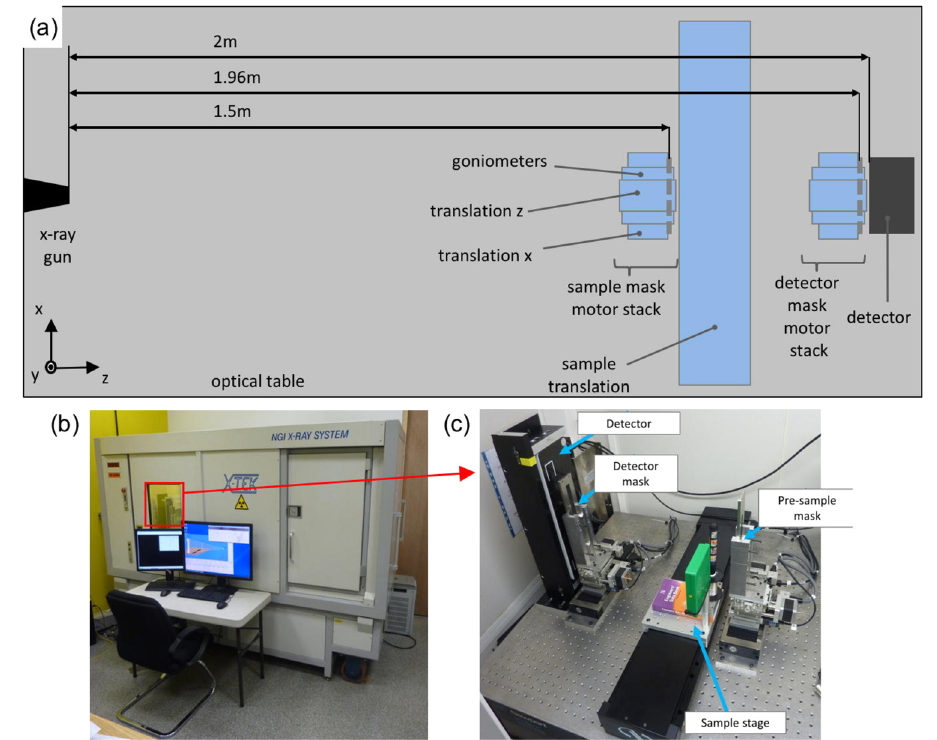
Fig. 5| Schematicand photosoftheimagingsystem. a shows aschematicof the imaging system, listing all components and their respective distances. All compo- nents are mounted on an optical table, placed inside the cabinet shown in b .